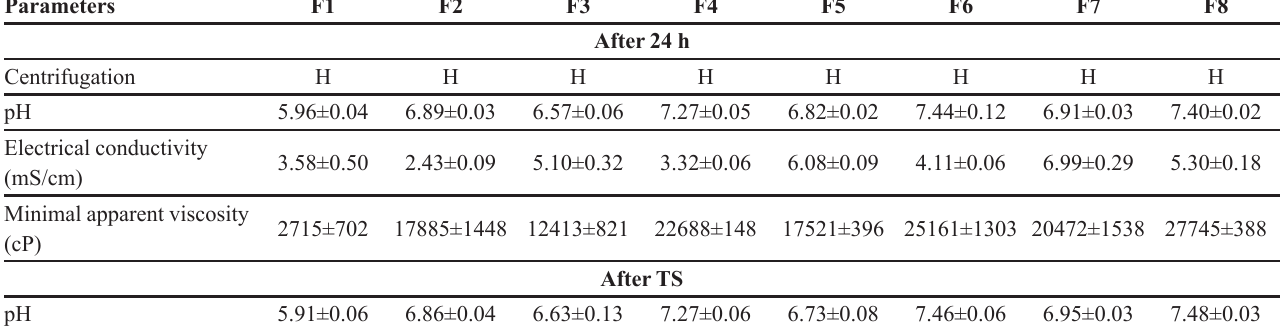
TABLE II - Results of preliminary stability tests of emulsions with or without Kalanchoe brasiliensis extract